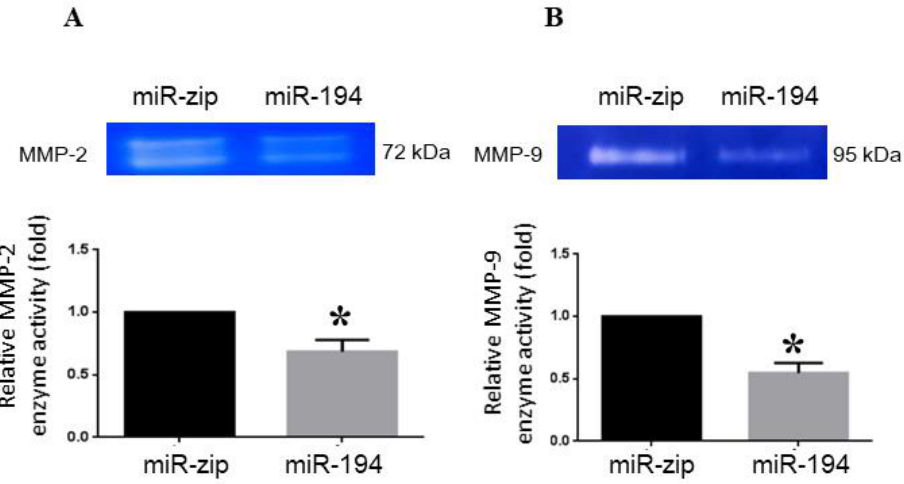
Figure 5. Effect of miR-194-5p on the enzyme activities of MMP-2 and MMP-9 in MDA-MB-231 cells: MDA-MB-231 cells were transfected with miR-194-5p precursors and control microRNA for 48 h, and the enzyme activities of MMP-2 ( A ) and MMP-9 ( B ) in conditioned media were analyzed zymography. *, p < by gelatin zymography. *, p < 0.05.